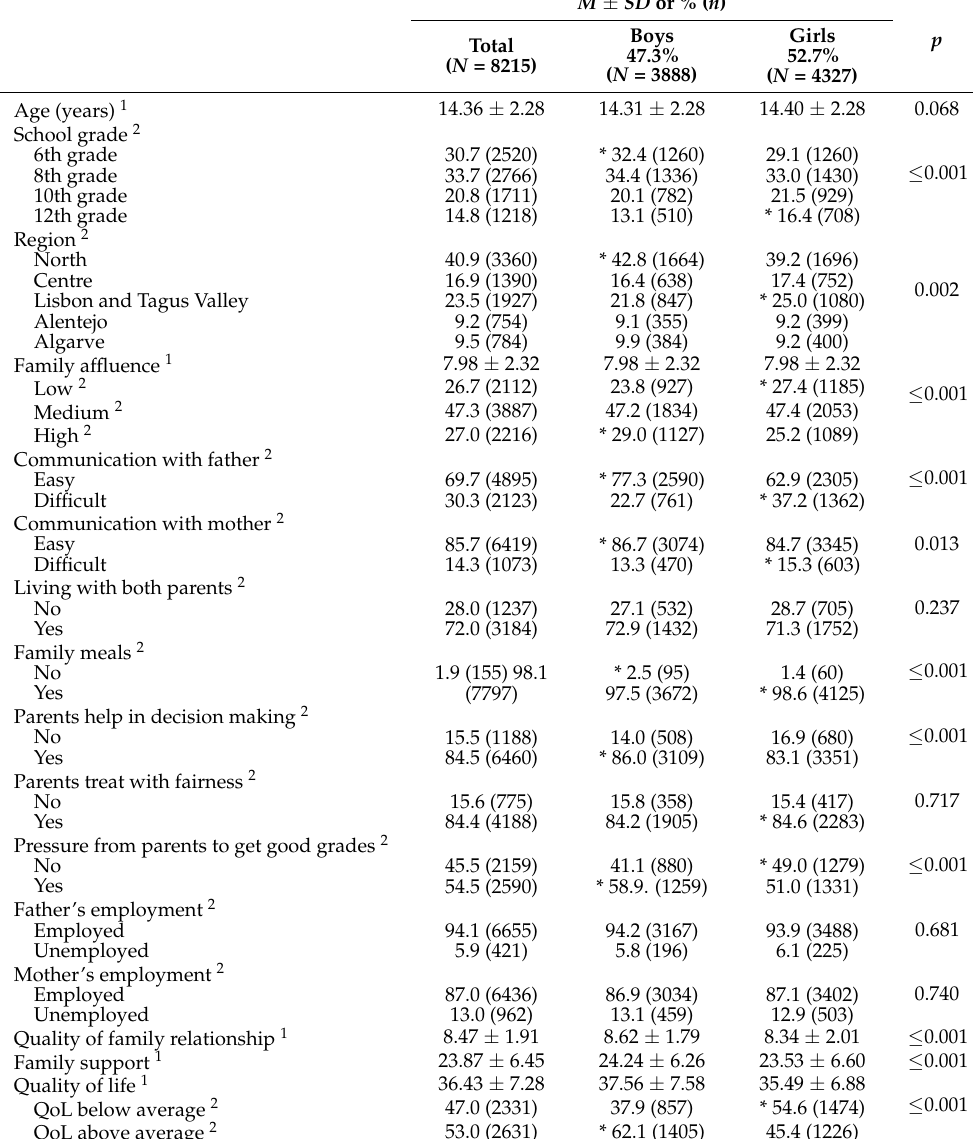
Table 2. Population